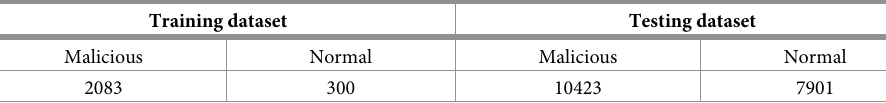
Table 6. Test and training dataset—SIP